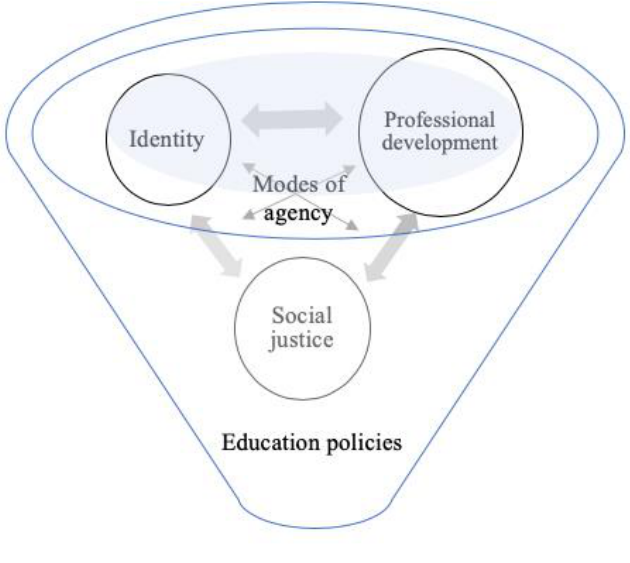
Figure 2. Thematic